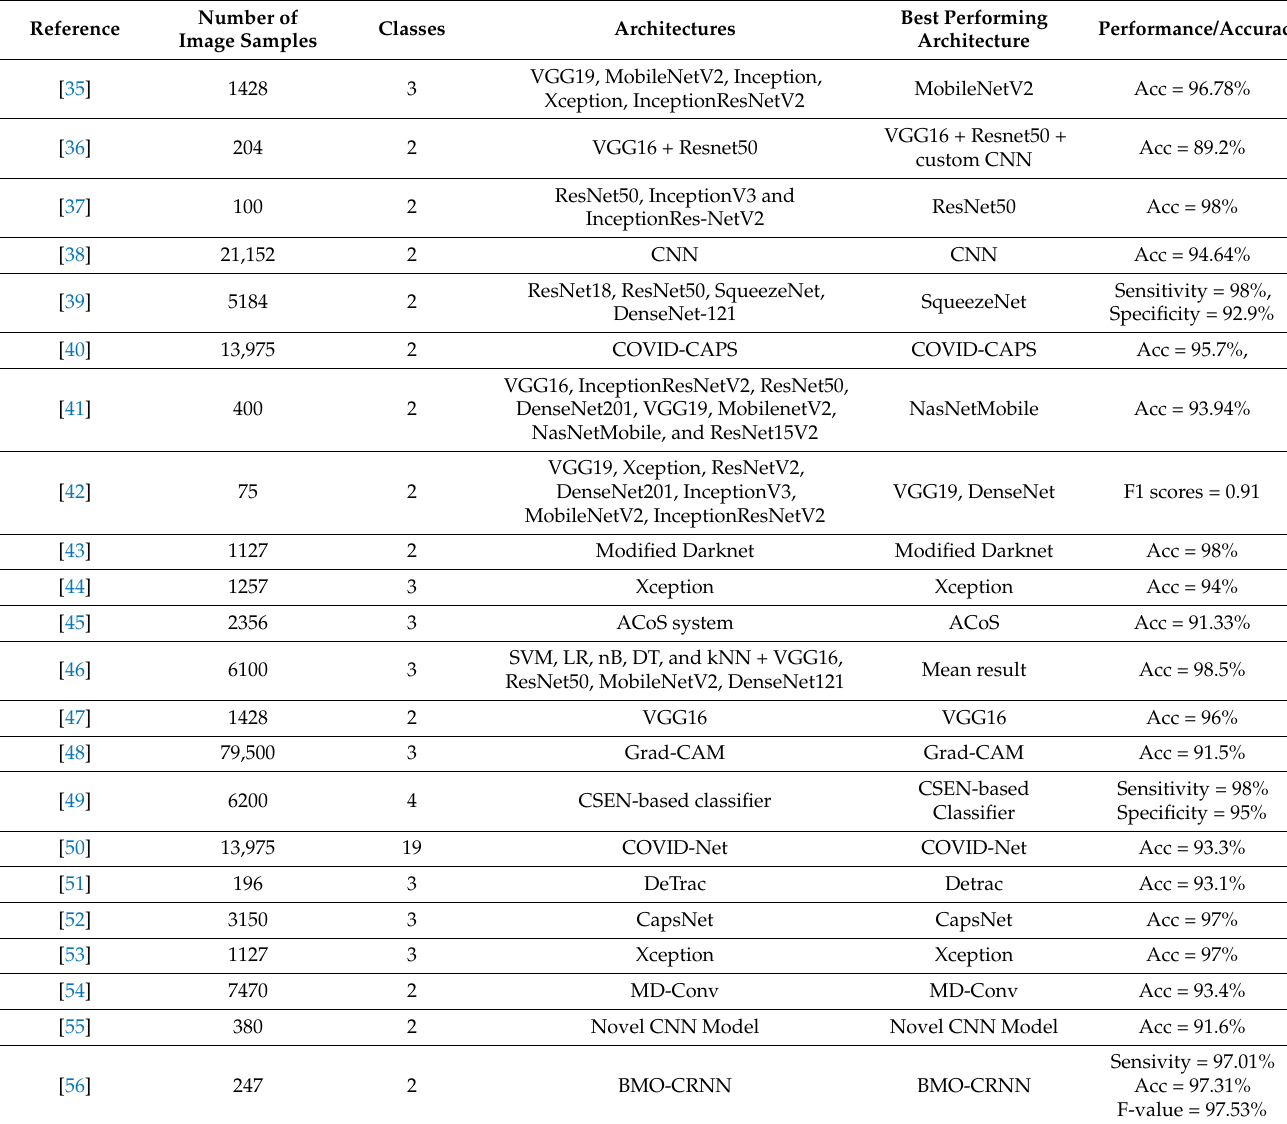
Table 1. Overview of studies using deep learning approaches with their performance for COVID-19 case detection. Number of Reference Image